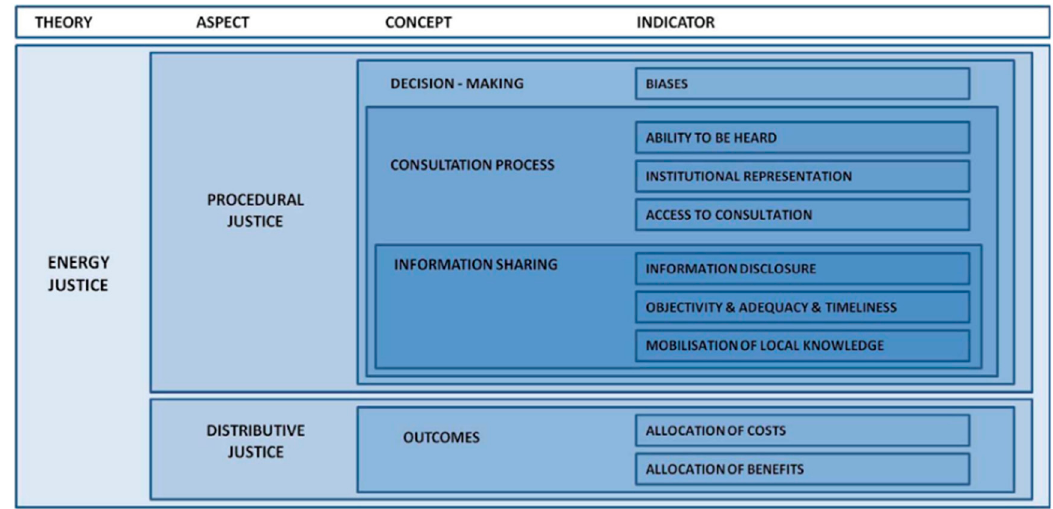
Figure 1. Overview of the conceptual and analytical framework of energy justice [12].